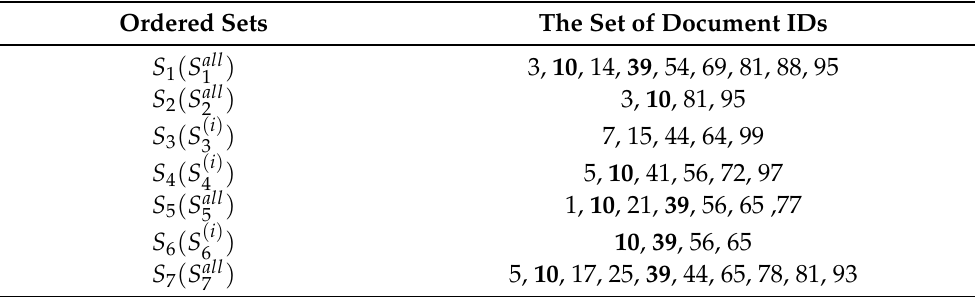
Table 1. An example of ordered sets in the edge server N i , where bold elements are the results for the running